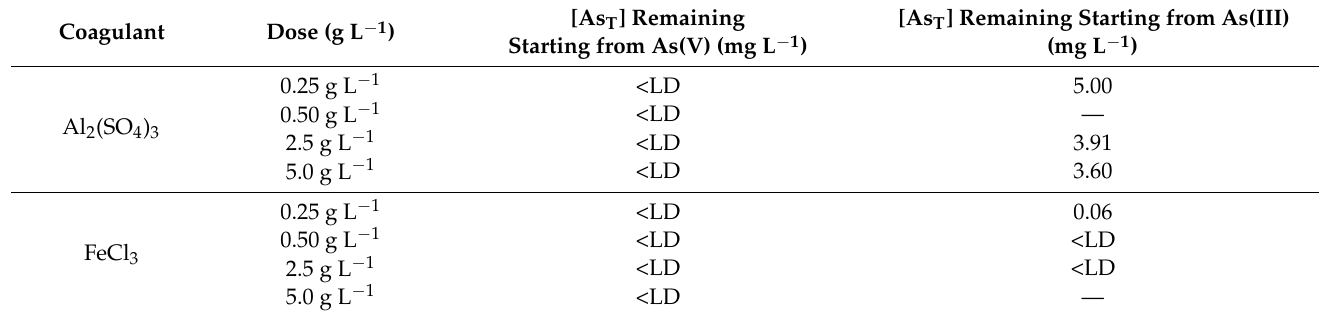
Table 3. Removal of As(V) and As(III) with coagulants-flocculants. Conditions: [As(V)] 0 or [As(III)] 0 = 5 mg L − 1 , pH 7, RT, EC = 0.03 mS cm − 1 (before adding the coagulant), mechanical agitation, reaction time: 15